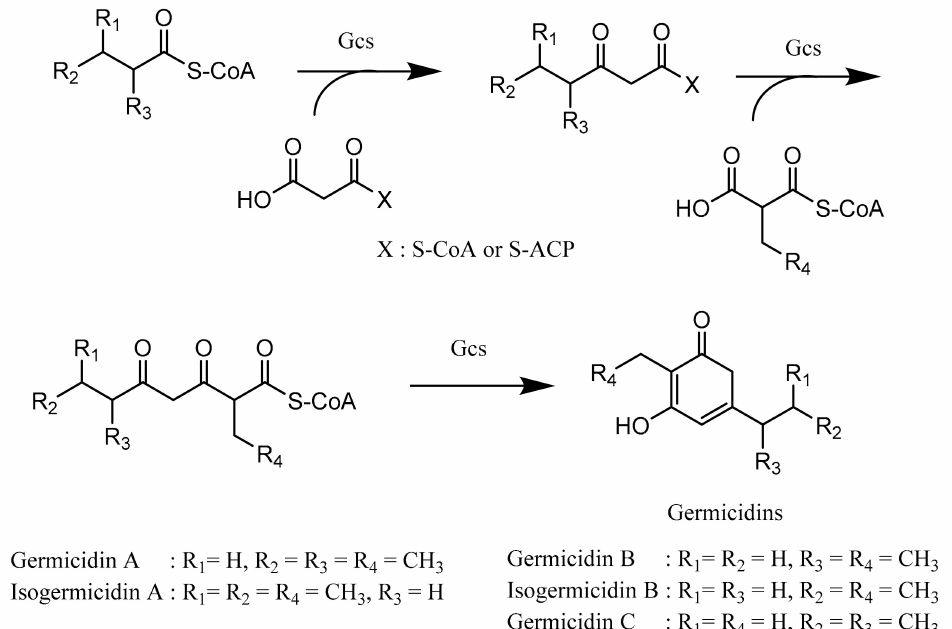
Figure 8. Biosynthesis of germicidins. Gcs: germicidin synthase. Adapted with permission from Song, L.; Barona-Gomez, F.; Corre, C.; Xiang, L.; Udwary, D.W.; Austin, M.B.; Noel, J.P.; Moore,